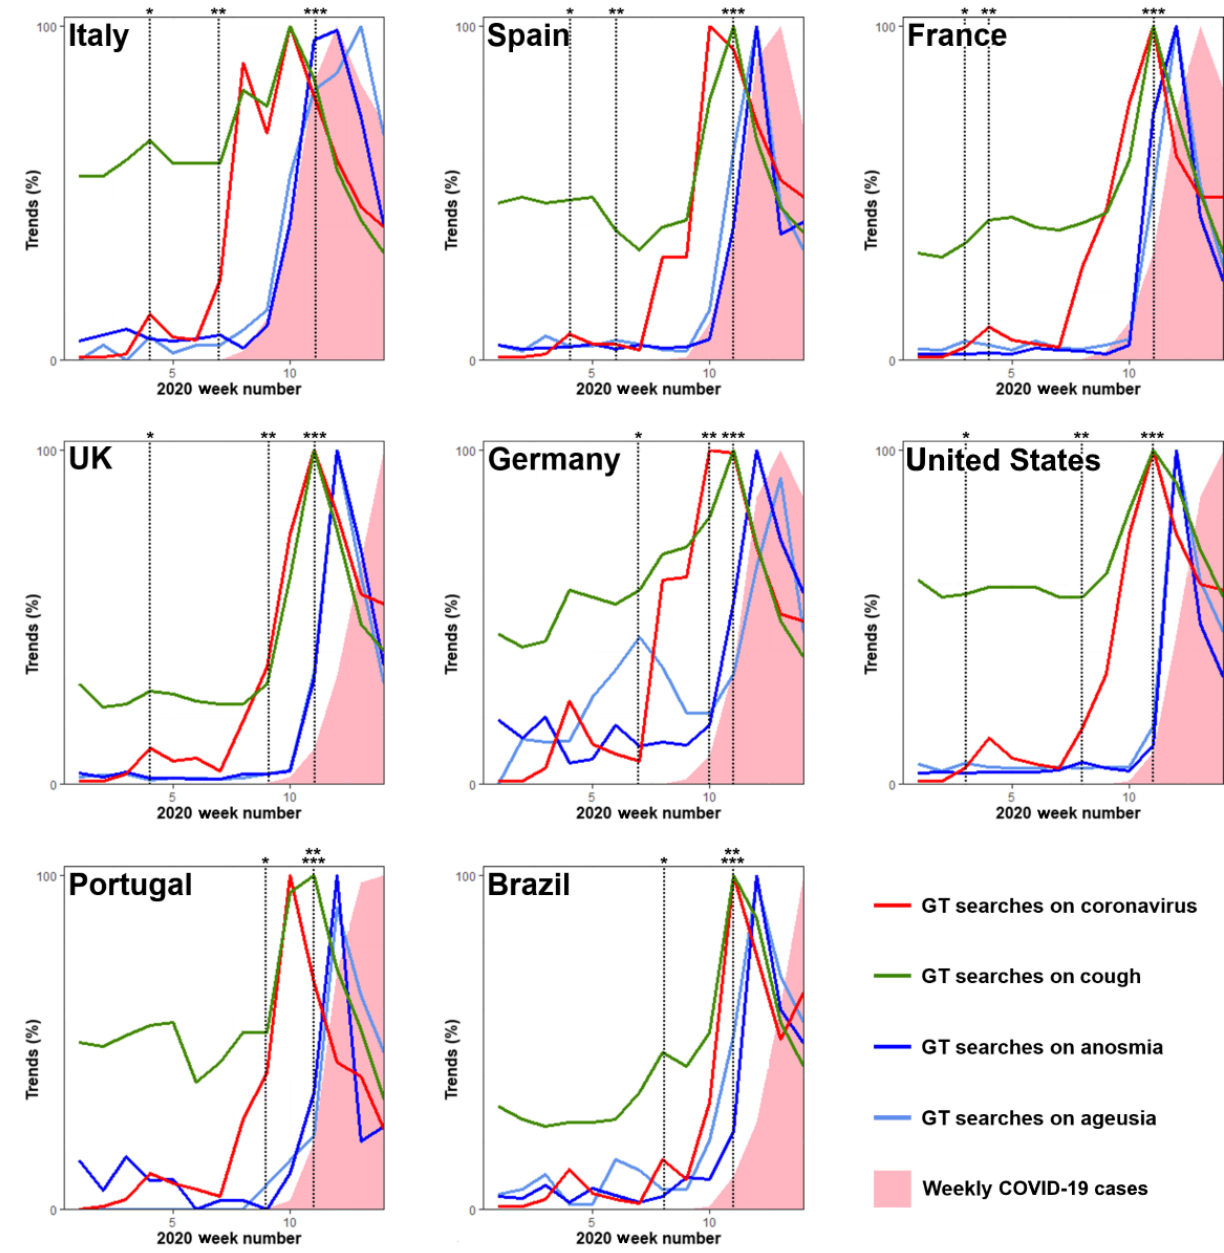
Figure 2. GT data for coronavirus , cough , anosmia , and ageusia and relative frequency of new COVID-19 infections. Data are presented as a percentage of the maximum value on a weekly basis, from the week of January 5 to 11, 2020, to the week of April 5 to 11, 2020. *First confirmed COVID-19 case. **First confirmed death due to COVID-19. ***Hendrik Streeck interview to Frankfurter Allgemeine Zeitung reporting that anosmia and ageusia can be COVID-19 symptoms. COVID-19: coronavirus disease. GT: Google